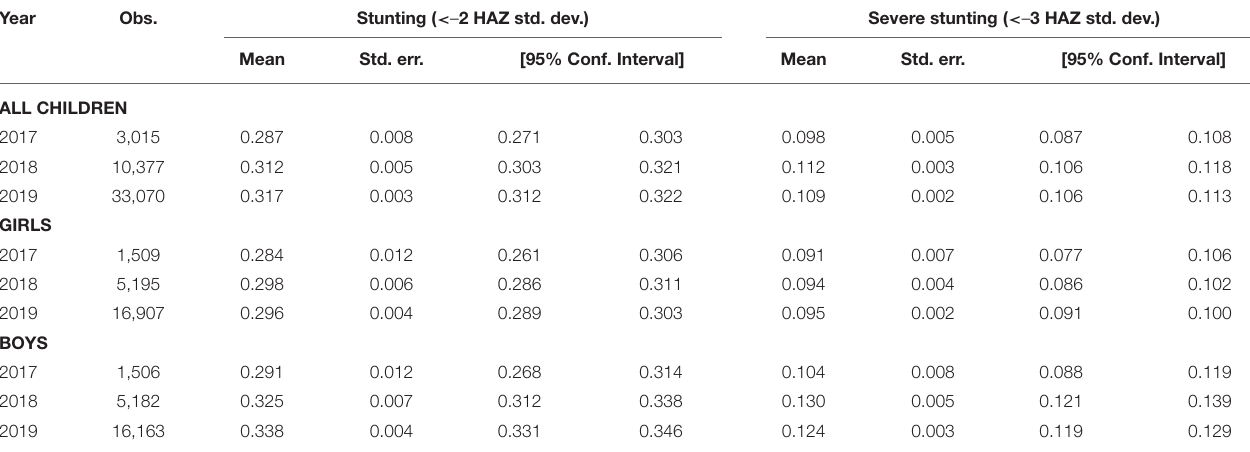
TABLE 2 | Prevalence of stunting and severe stunting in program’s children. Year Obs. Stunting ( < – 2 HAZ std. dev.) Severe stunting ( < – 3 HAZ std. dev.) Mean Std. err. [95% Conf. Interval] Mean Std. err. [95% Conf. Interval]